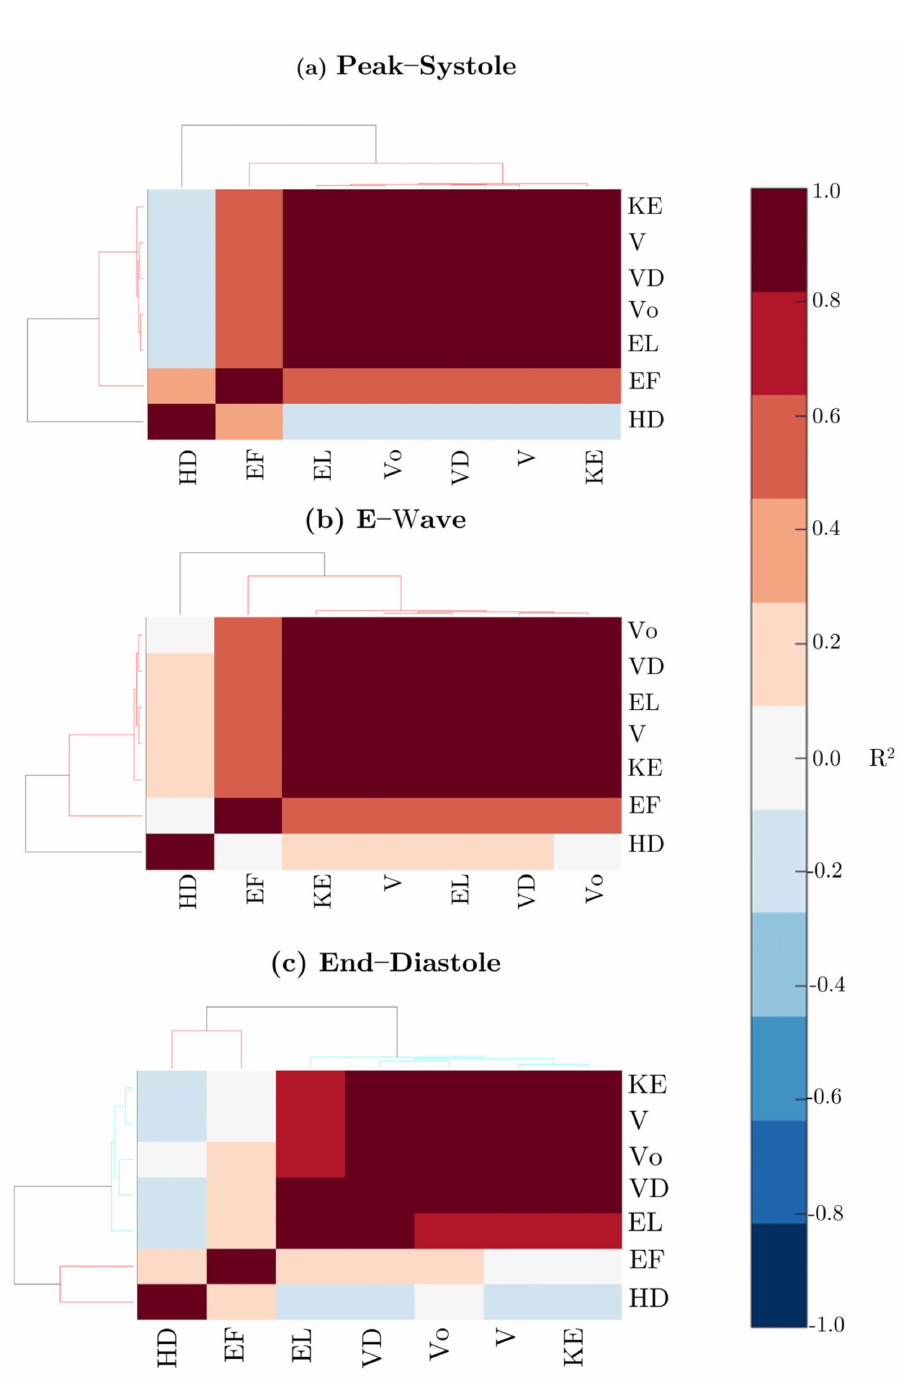
Figure 3. Dendrogram and hierarchical clustering results based on average linkage method for ejection fraction and hemodynamic parameters. EF: ejection fraction, V: velocity, KE: kinetic energy, Vo: vorticity, HD: helicity density, VD: viscous dissipation, and EL: energy